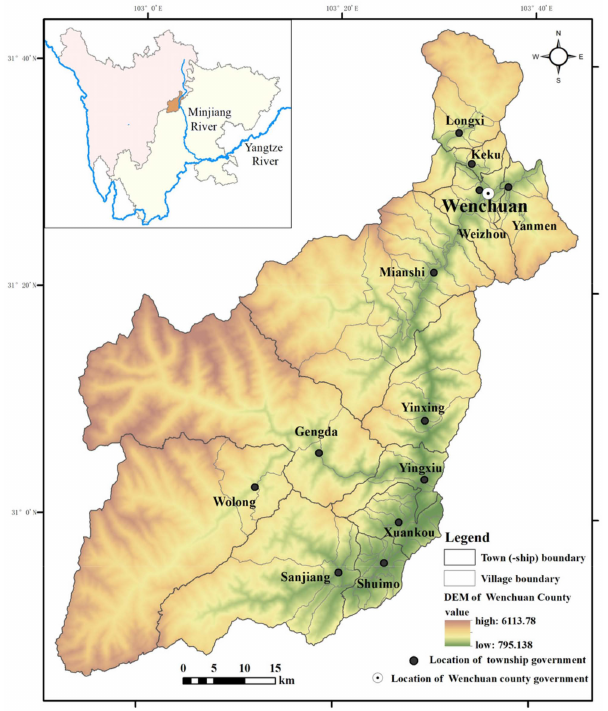
Figure 1. The spatial distribution of villages and towns in Wenchuan